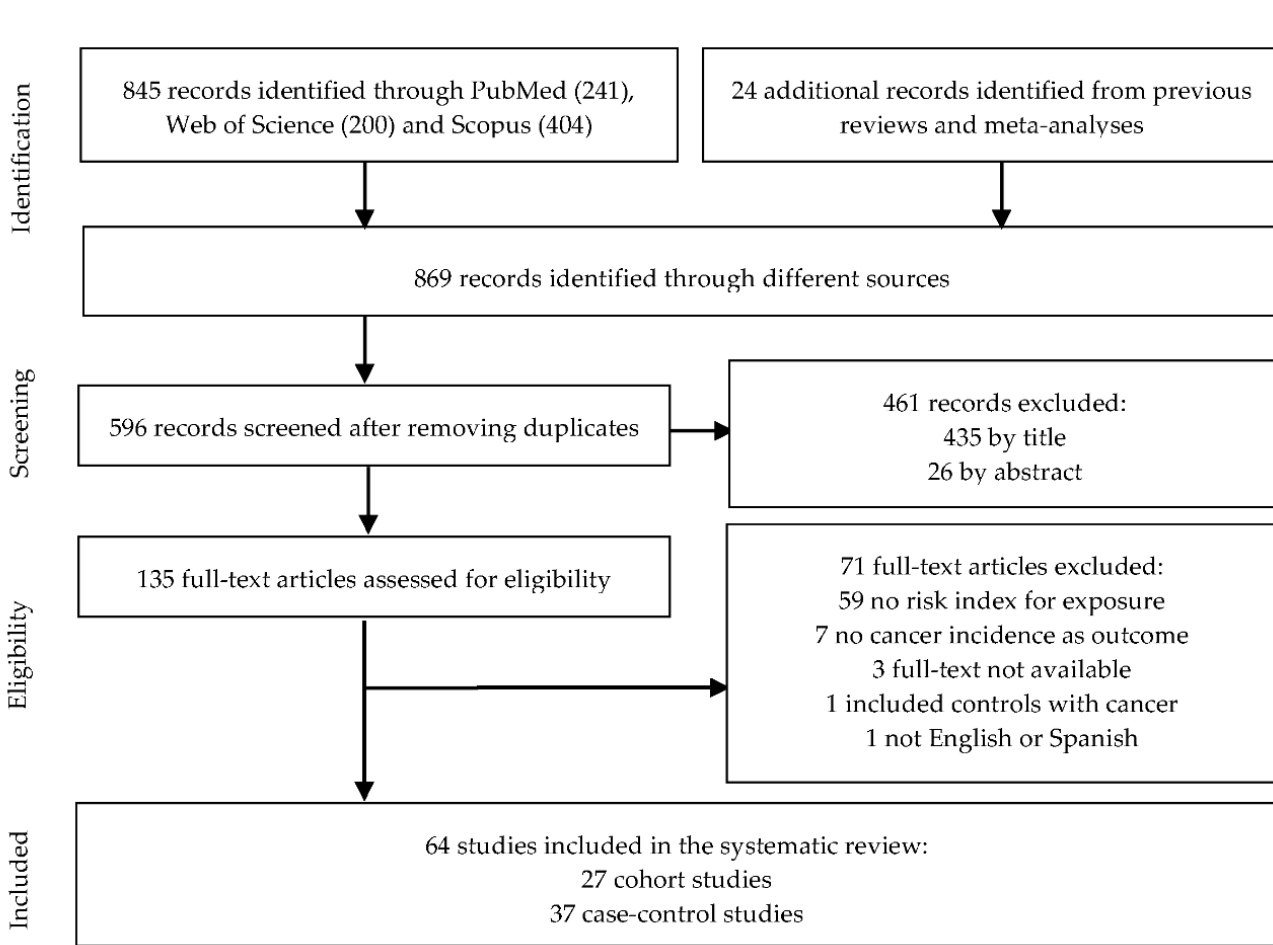
Table 1. Results of the meta-analysis for the random-effect model are summarized in Table 2 and for the subgroup analysis in Table